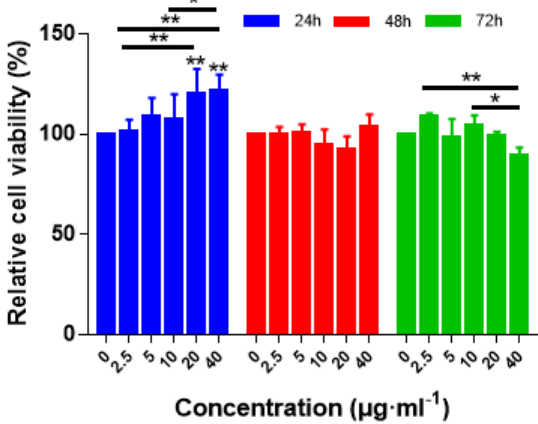
Figure 9. Cell viability of RLTAs (R:T = 2:1) on the growth of the cartilage cells TC-28a2. The cells have been treated with one of three treating times with various concentration for 24, 48, or 72 h at concentrations of 2.5, 5, 10, 20, and 40 µ g / mL. Results represent the means of three independent experiments and error bars represent the standard error of the mean. Statistical significance was assessed using two-way ANOVAs with Tukey’s multiple comparison tests ( ∗ p < 0.05, ∗∗ p < 0.01).